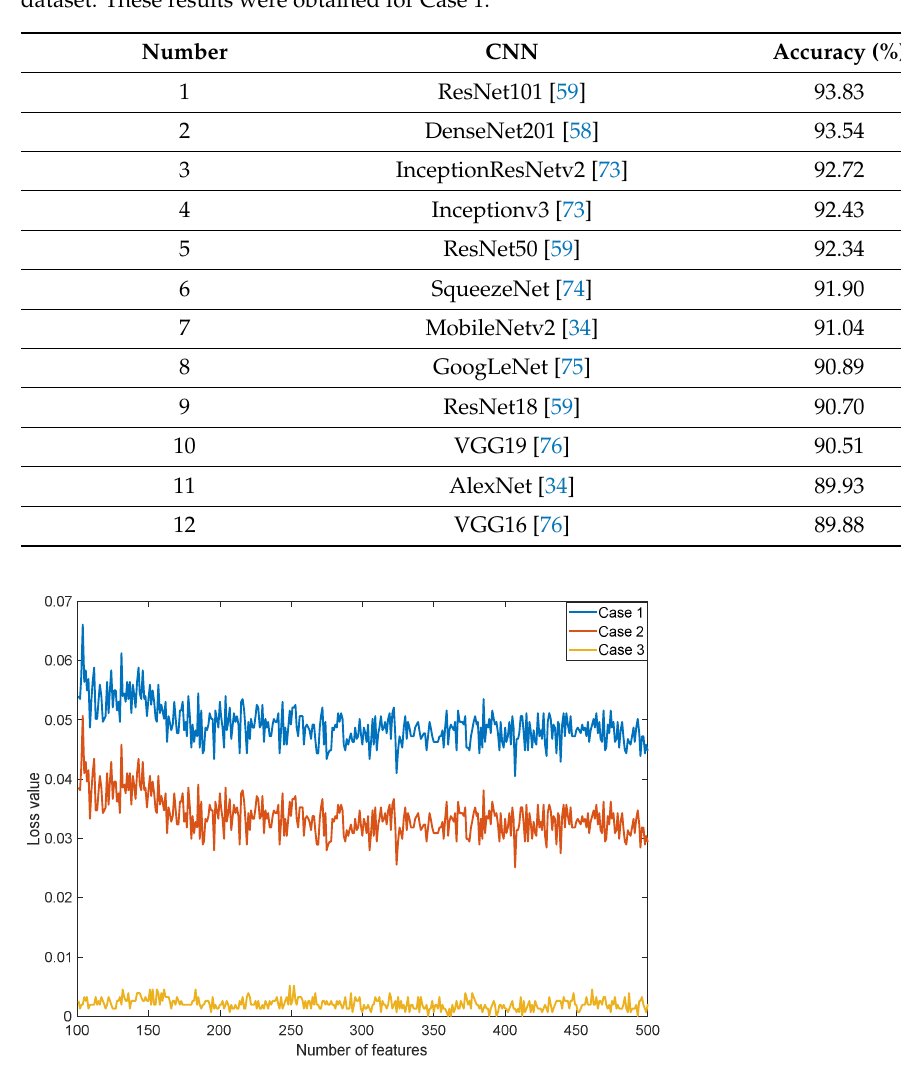
Table 4. Accuracy results obtained using various transfer learning models with our face mask image dataset. These results were obtained for Case 1.